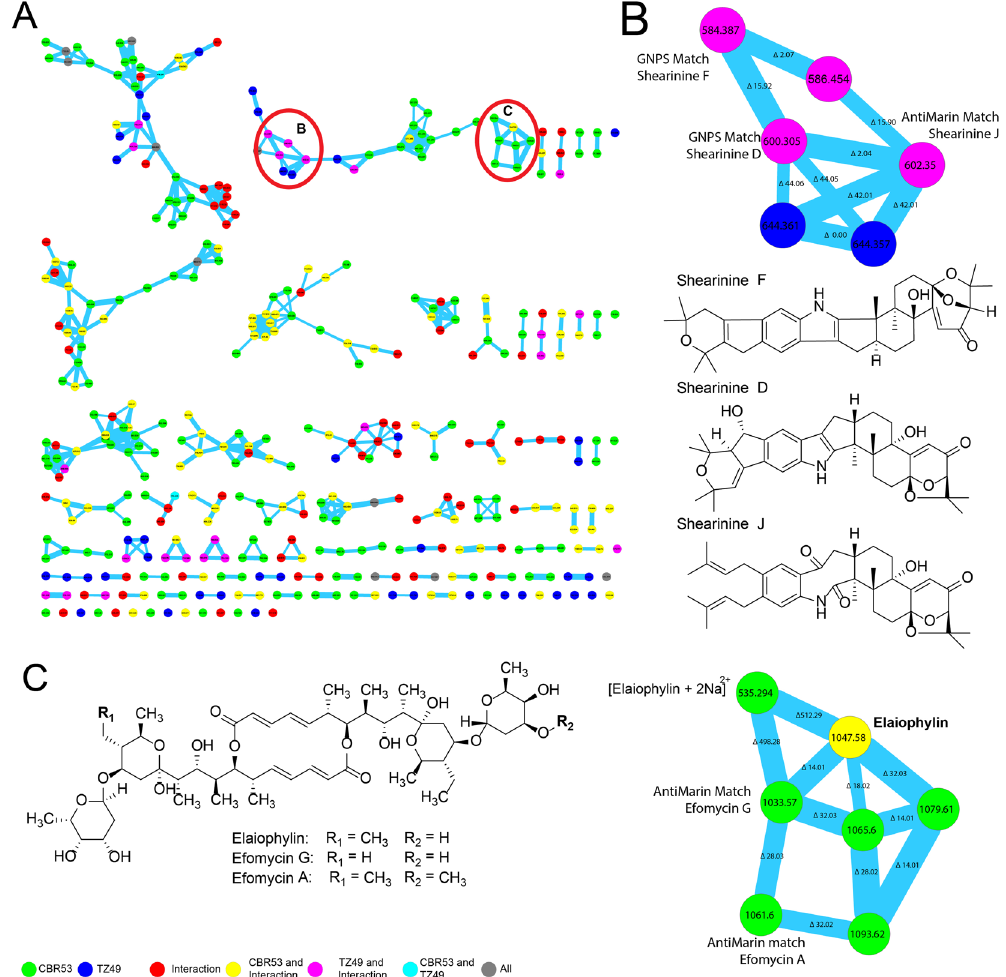
Figure 2. Molecular network from the extract of the bacterium Streptomyces CBR53 with the identification of the elaiophylin macrolide. ( A ) Molecular network after filter blanks, colors indicate producers of the nodes: Streptomyces CBR53 green; Escvopsis TZ49 blue, Streptomyces sp. vs Escovopsis sp. (CBR53 vs TZ49) red. Nodes found in more than one producers are represented as combination of their colors: Streptomyces CBR53, Streptomyces sp. vs Escovopsis sp. (CBR53 vs TZ49) yellow; Escovopsis TZ49, Streptomyces sp. vs Escovopsis sp (CBR53 vs TZ49) pink; Streptomyces CBR53, Escvopsis TZ49 cian. ( B ) Enlarged cluster of shearinine derivatives indicating their location in the sub-network, chemical structures of shearinine D, shearinine F and shearinine J. ( C ) Chemical structures of elaiophylin, efomycin G and efomycin A macrolides dereplicated using GNPS and AntiMarin, enlarged cluster denoting their location in the